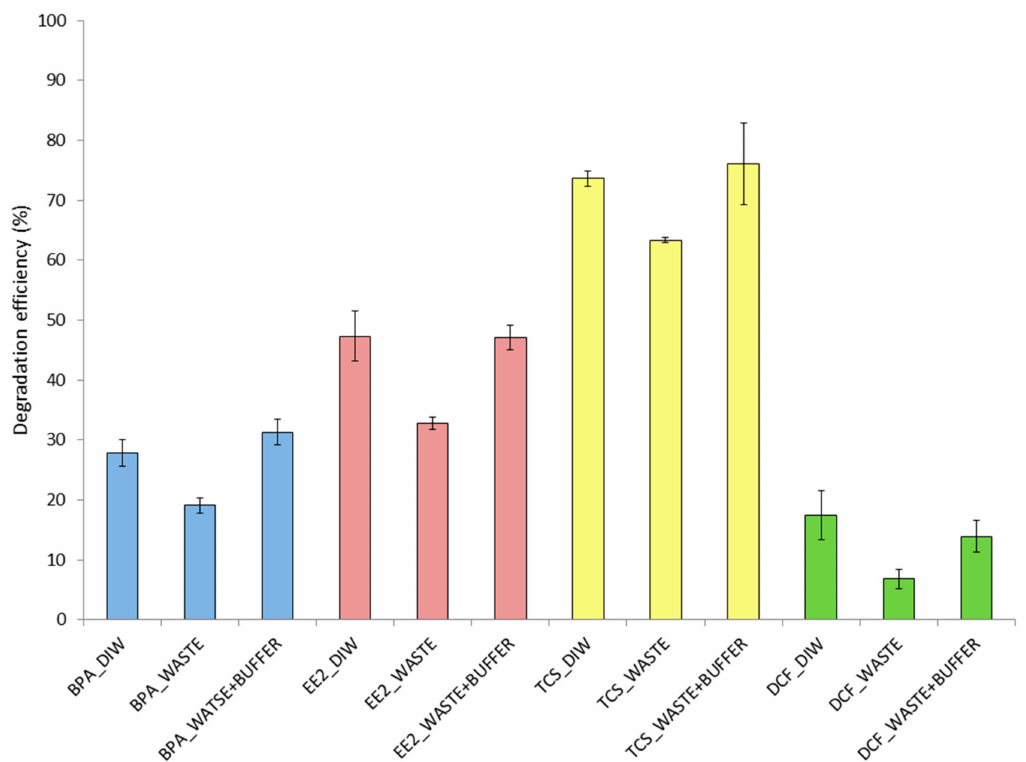
Figure 6. Degradation e ffi ciency of immobilized laccase (PA / PEI-laccase) towards a mixture of 10 mg / mL of bisphenol A (BPA), 17 α -ethinylestradiol (EE2), triclosan (TCS), and diclofenac (DCF), in deionized water (DIW), wastewater e ffl uent (WASTE), and wastewater infused with 2.5% ( v / v ) of McIlvaine’s bu ff er of pH 7 (WASTE +